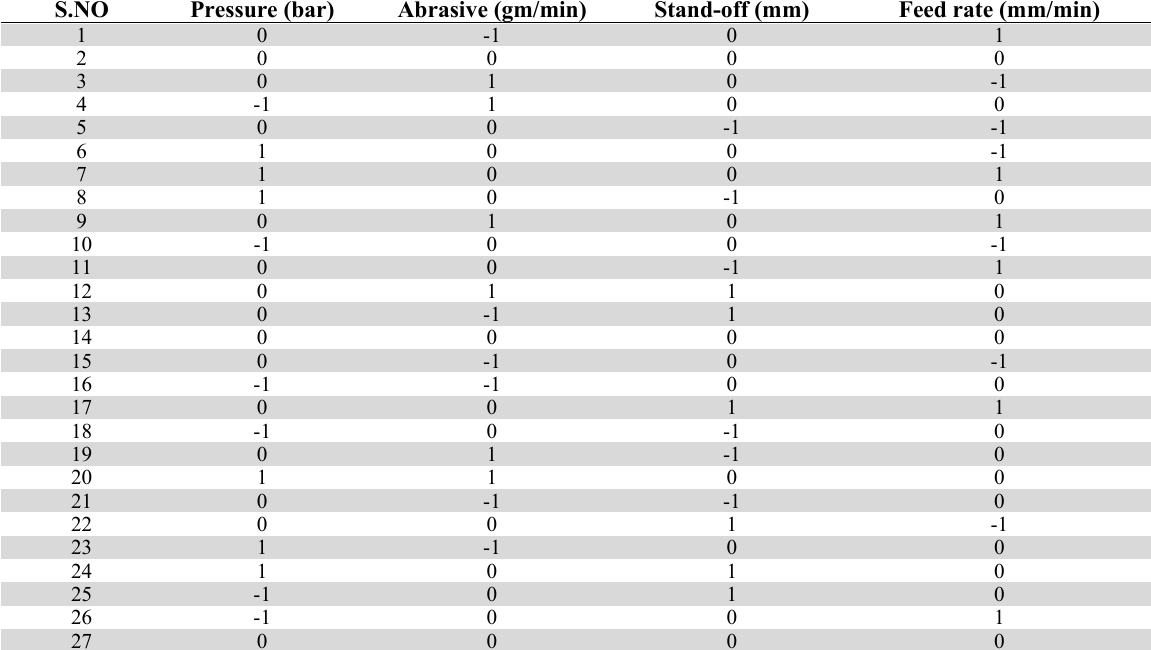
Box Behnken Experimental design